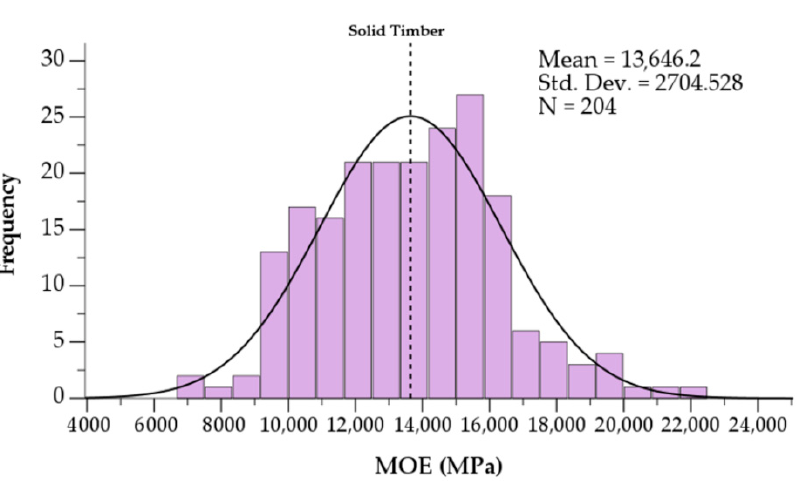
Figure 6. Histogram of MOE of solid timber specimens from the outer layers of E. nitens CLT for a population of 204 specimens.